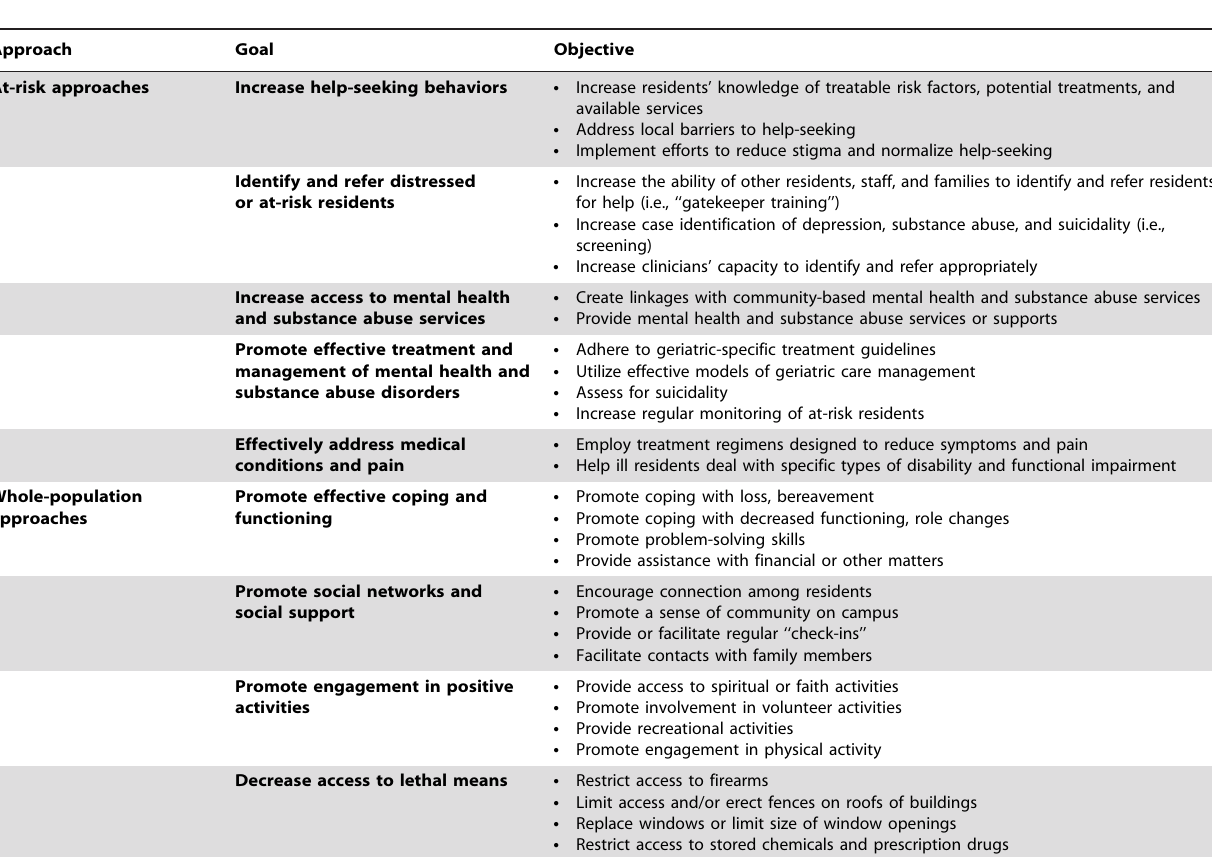
Table 1. Opportunities for suicide prevention interventions in senior living communities.